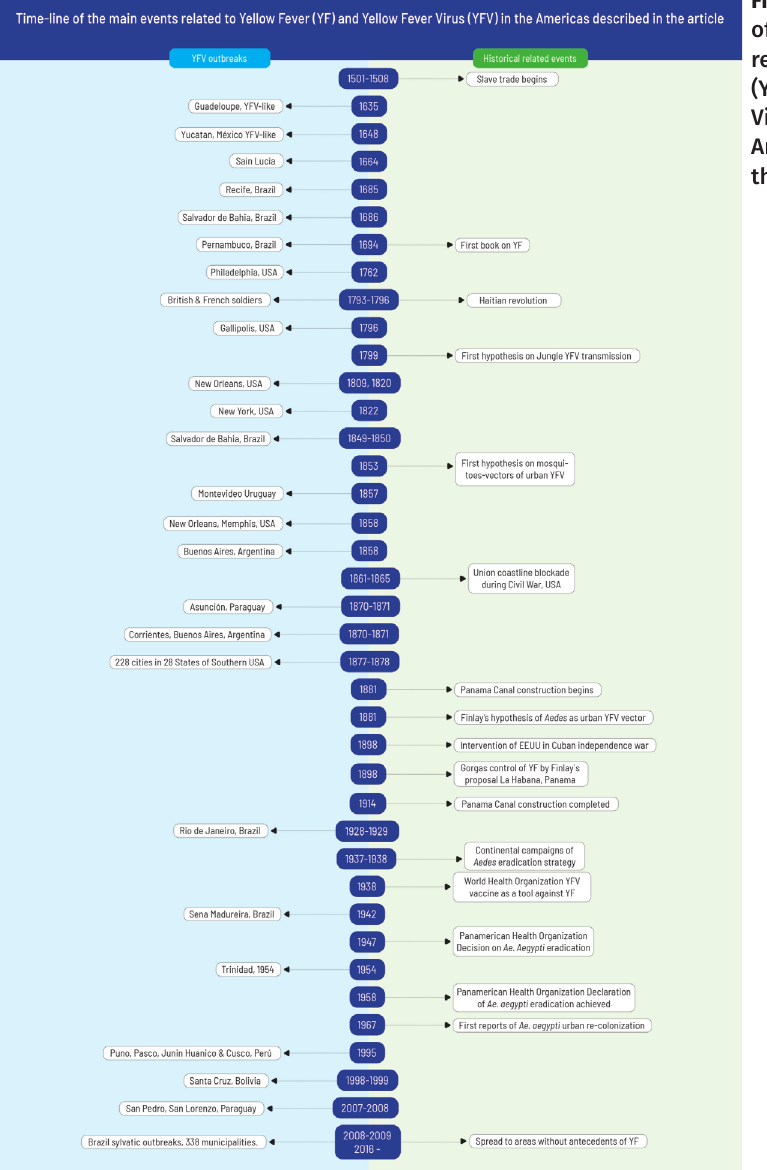
Figure 1. Time-line of the main events related to Yellow Fever (YF) and Yellow Fever Virus (YFV) in the Americas described in the